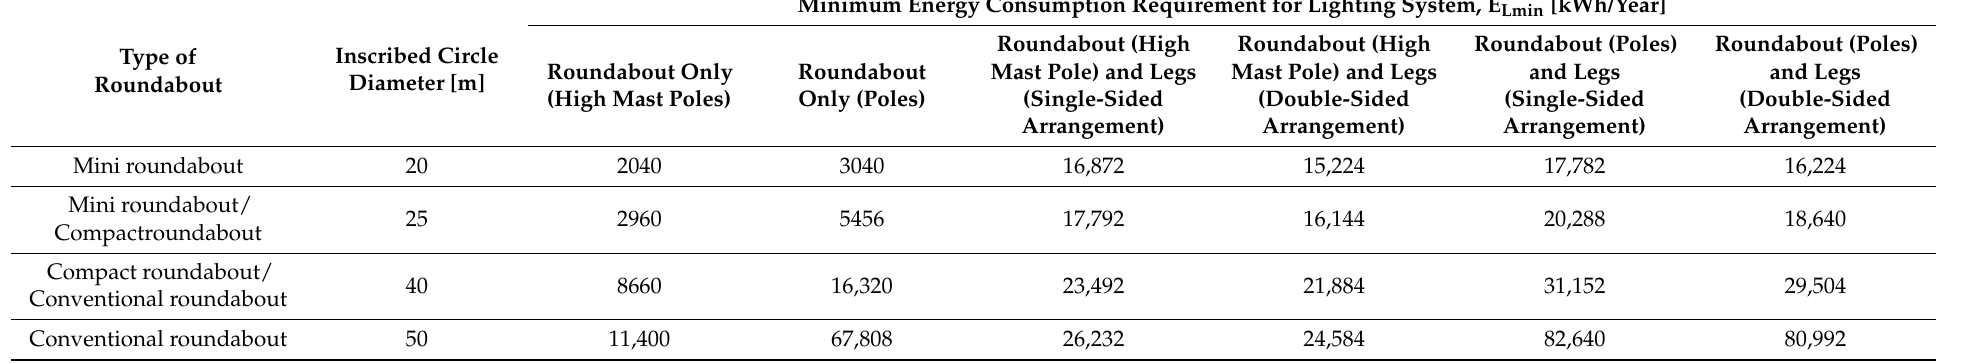
Table 6. Minimum energy consumption requirements for lighting systems in roundabouts.